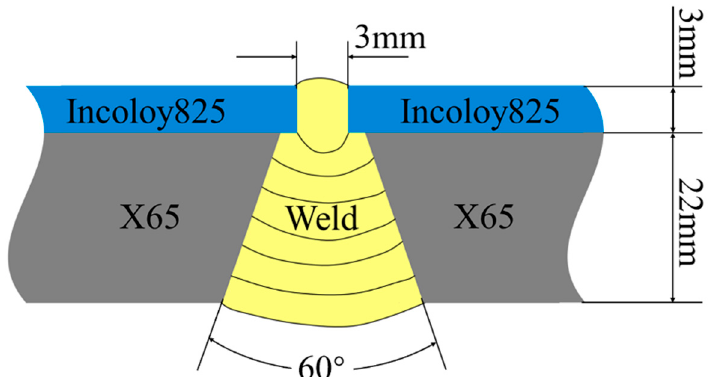
Figure 1. Schematic diagram of X65/Incoloy825 bimetallic composite pipe.